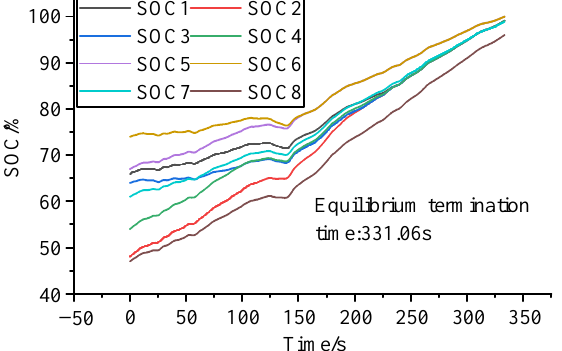
Figure 16. Lithium battery SOC change chart. (Adjacent equalisation circuits and fuzzy control strategies)